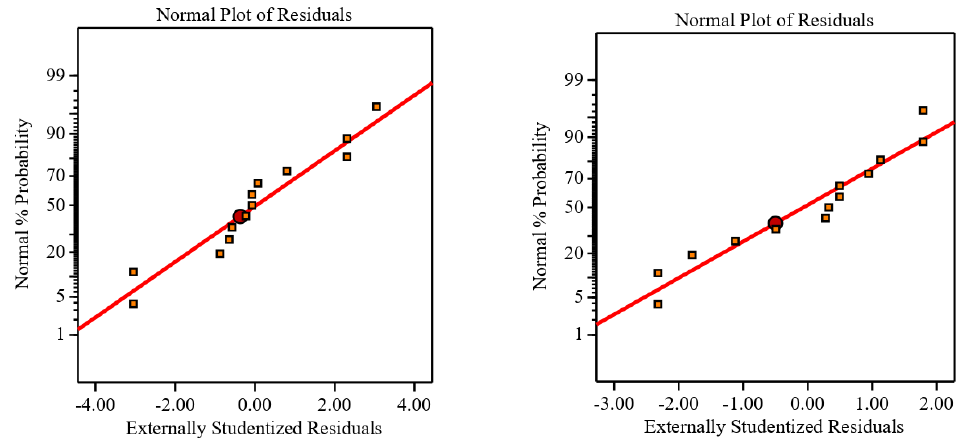
Materials 2023 , 16 , x FOR PEER REVIEW Figure 17. Normal probability plot in the left for Ti-6Al-4V and in the right for Ti-6Al-7Nb.